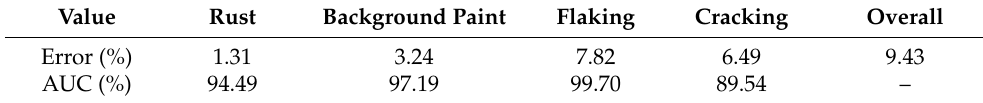
Table 1. Error rates and segmentation accuracy of the developed